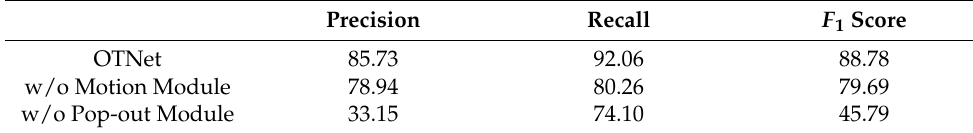
Table 8. The w/o experiments’